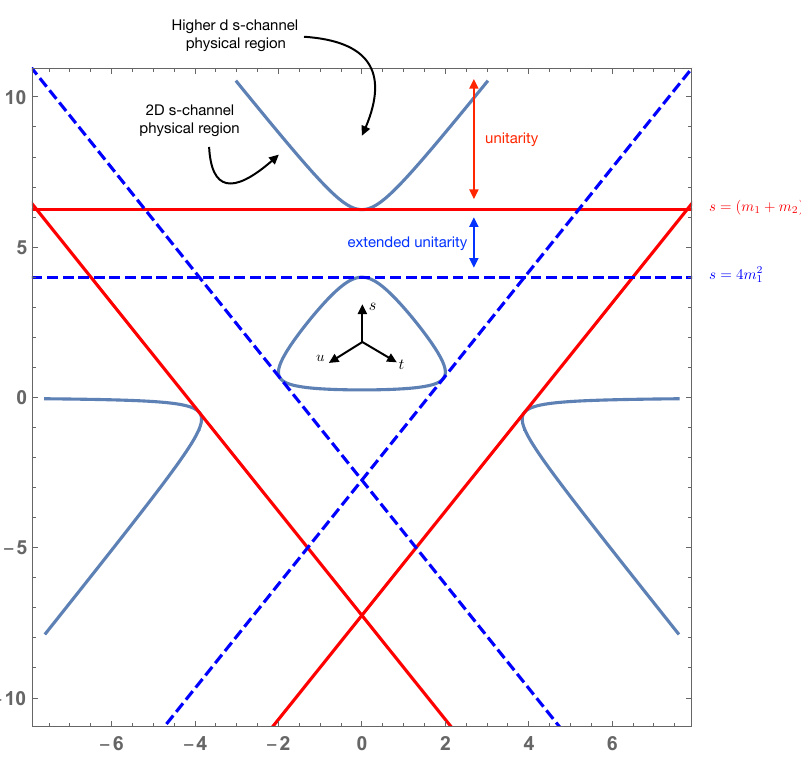
Figure 3 . Maldelstam Triangle for 11 → 12 scattering. The x-axis is given by x = ( s + 2 t − 3 m 2 √ m 2 ) / 3 . The 11 → 12 scattering if fully crossing invariant and indeed so is this picture. Physical 2 processes in 2D lie on top of the blue solid lines and outside the red lines; in higher dimensions they fill in the interior of the regions delimited by the blue solid lines as one scans over physical scattering angles. Similar triangle for 12 → 12 scattering can be found in